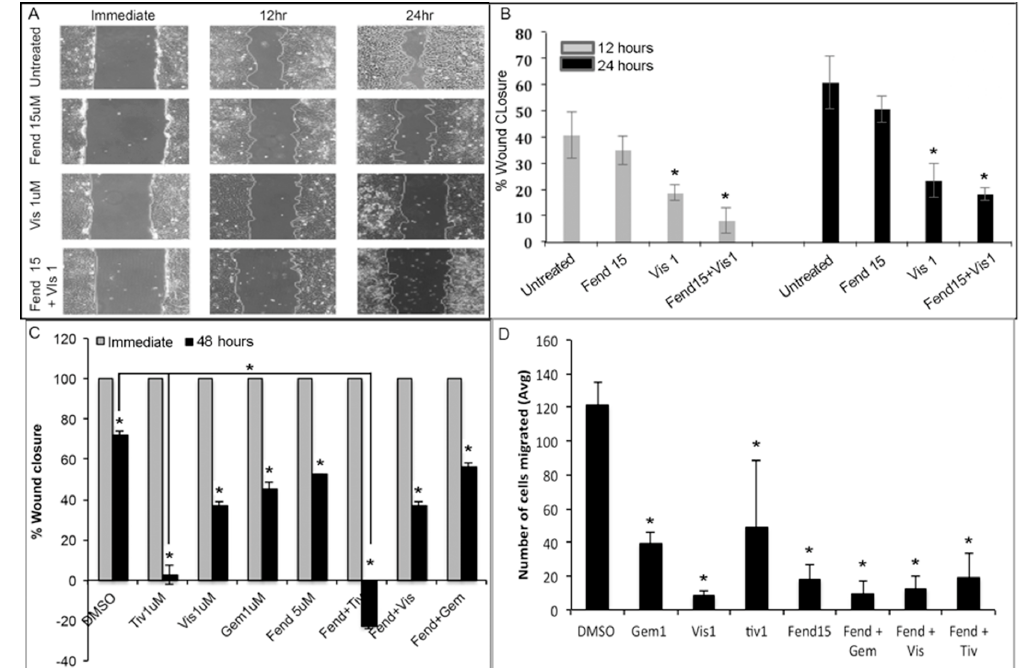
Figure 3. Panc1 cells treated with combination of visudyne and fendiline show significantly